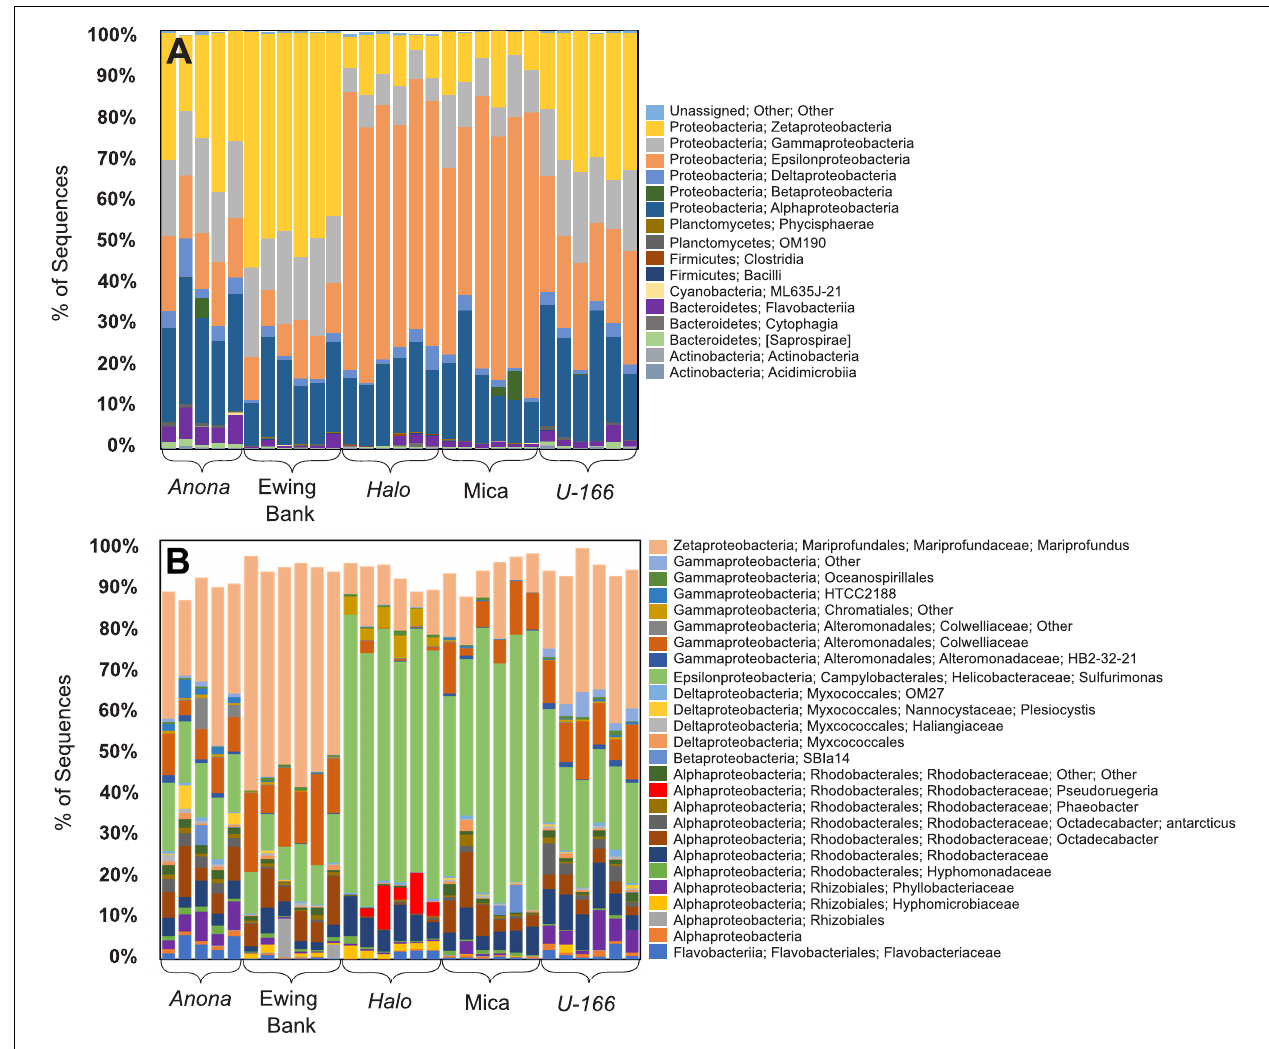
FIGURE 3 | Class level (A) and OTU level (B) bacterial community composition (16S rRNA) in replicate biofilm